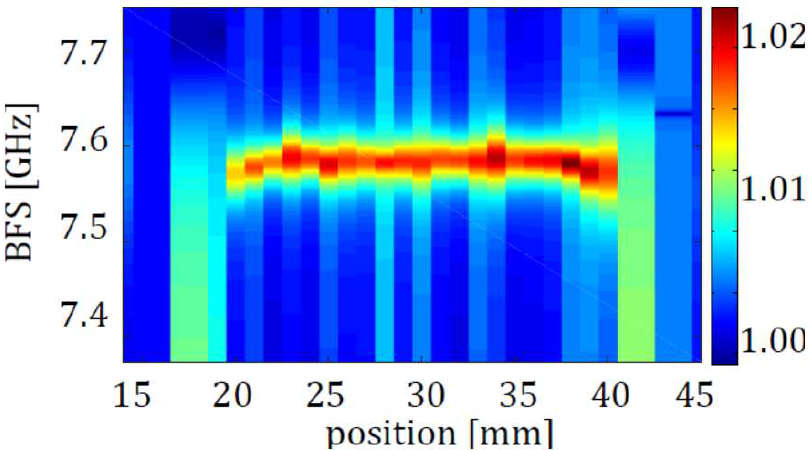
Figure 12. ASE B-OCDA map of Brillouin gain as a function of frequency offset between pump and signal waves and correlation peak position [33]. Measurements were performed over a 20-mm-long chalcogenide glass waveguide with a spatial resolution of 800 µm [33]. Reproduced with permission from [33], American Institute of Physics, 2018.